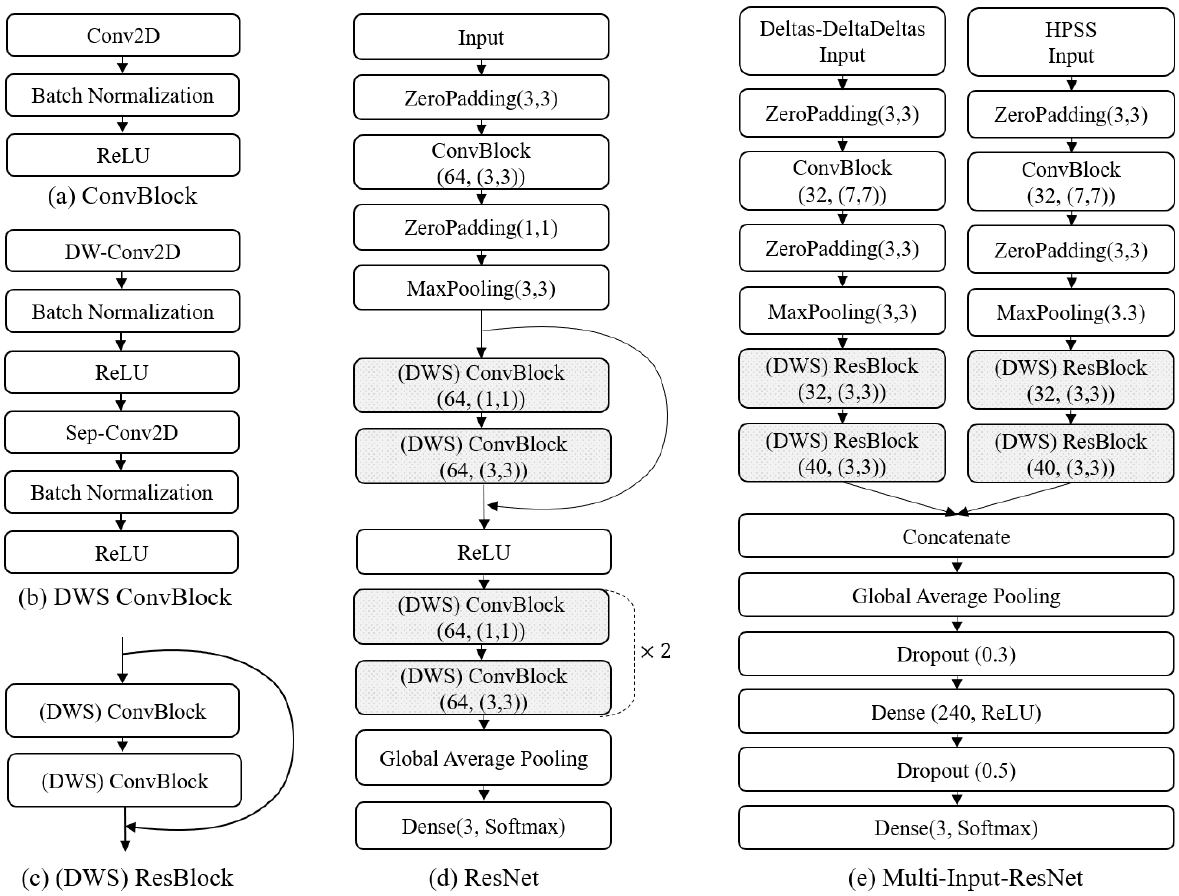
Figure 4. Architecture for subtask B. ( a ) and ( b ) describe submodules ConvBlock and depthwise separable ConvBlock. ( c ) describe ResBlock. ( d ) Proposed reduced ResNet model. ( e ) Proposed multi-input ResNet